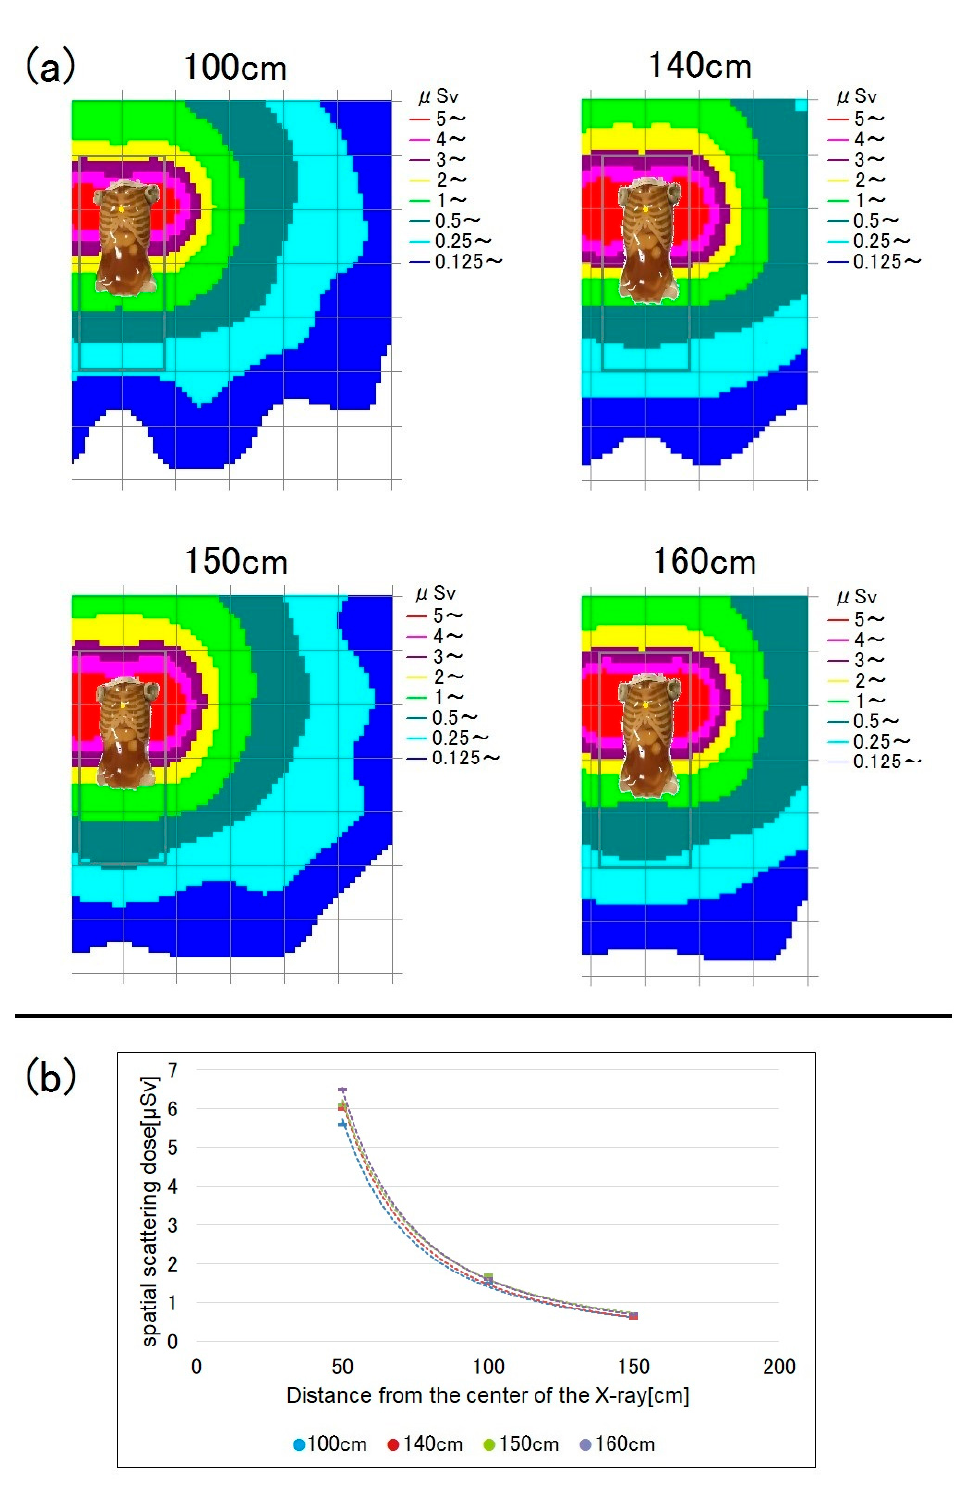
Figure 6. Spatial scattered radiation dose by measurement height at a bed height of 80 cm. ( a ) Dose-distribution map and ( b ) graph showing the spatial doses.